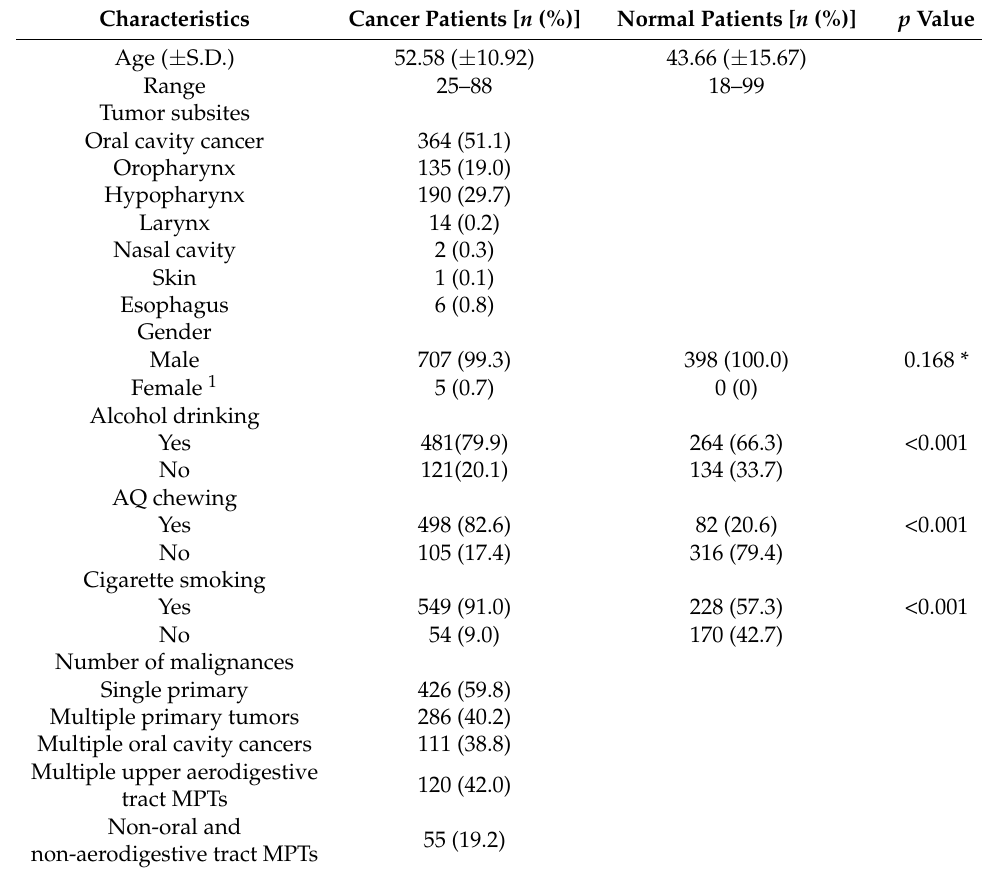
Table 1. The demographic data in the cohort of primary and multiple primary tumors for SNP array study ( n =